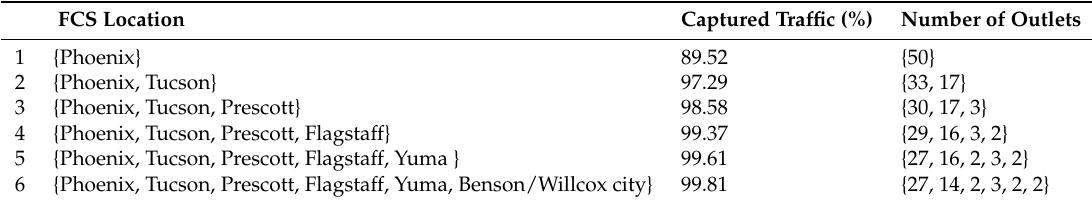
Table 2. Optimal charging outlet